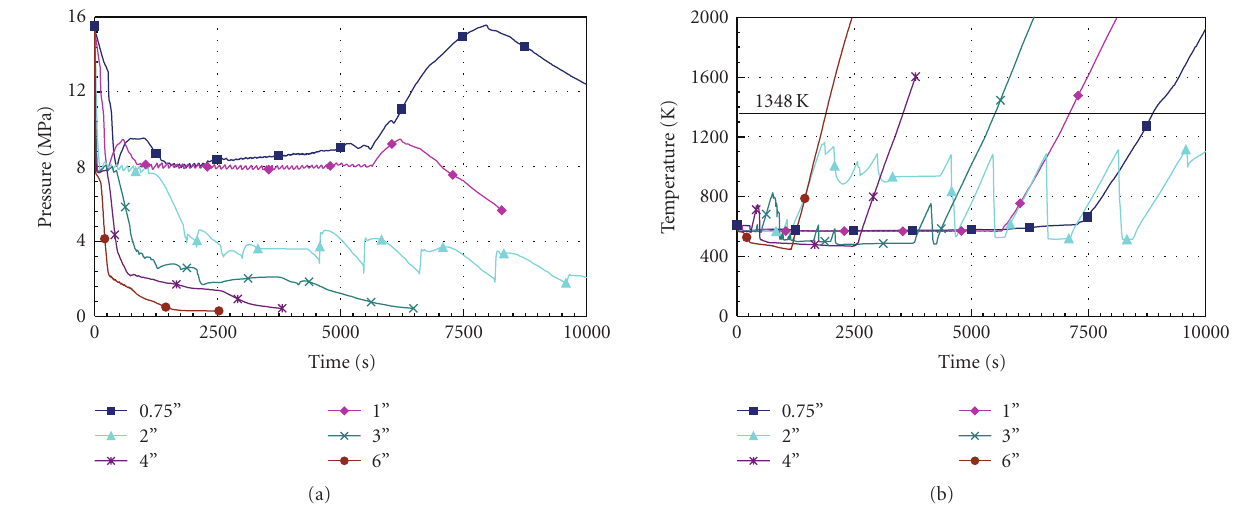
Figure 6: LOCA spectrum without SI actuation: (a) RCS pressure, (b) core cladding temperature.